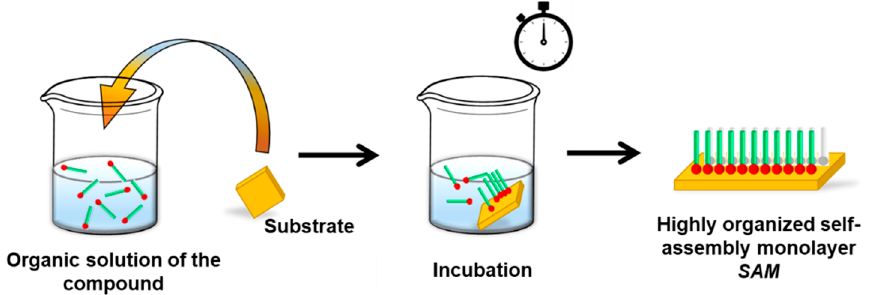
Figure 2. Scheme that illustrates the procedure for the preparation of a self-assembled monolayer. First, a clean substrate is incubated in a solution containing the molecules of interest for a certain time. Second, the substrate is withdrawn and thoroughly rinsed to remove the physisorbed material.